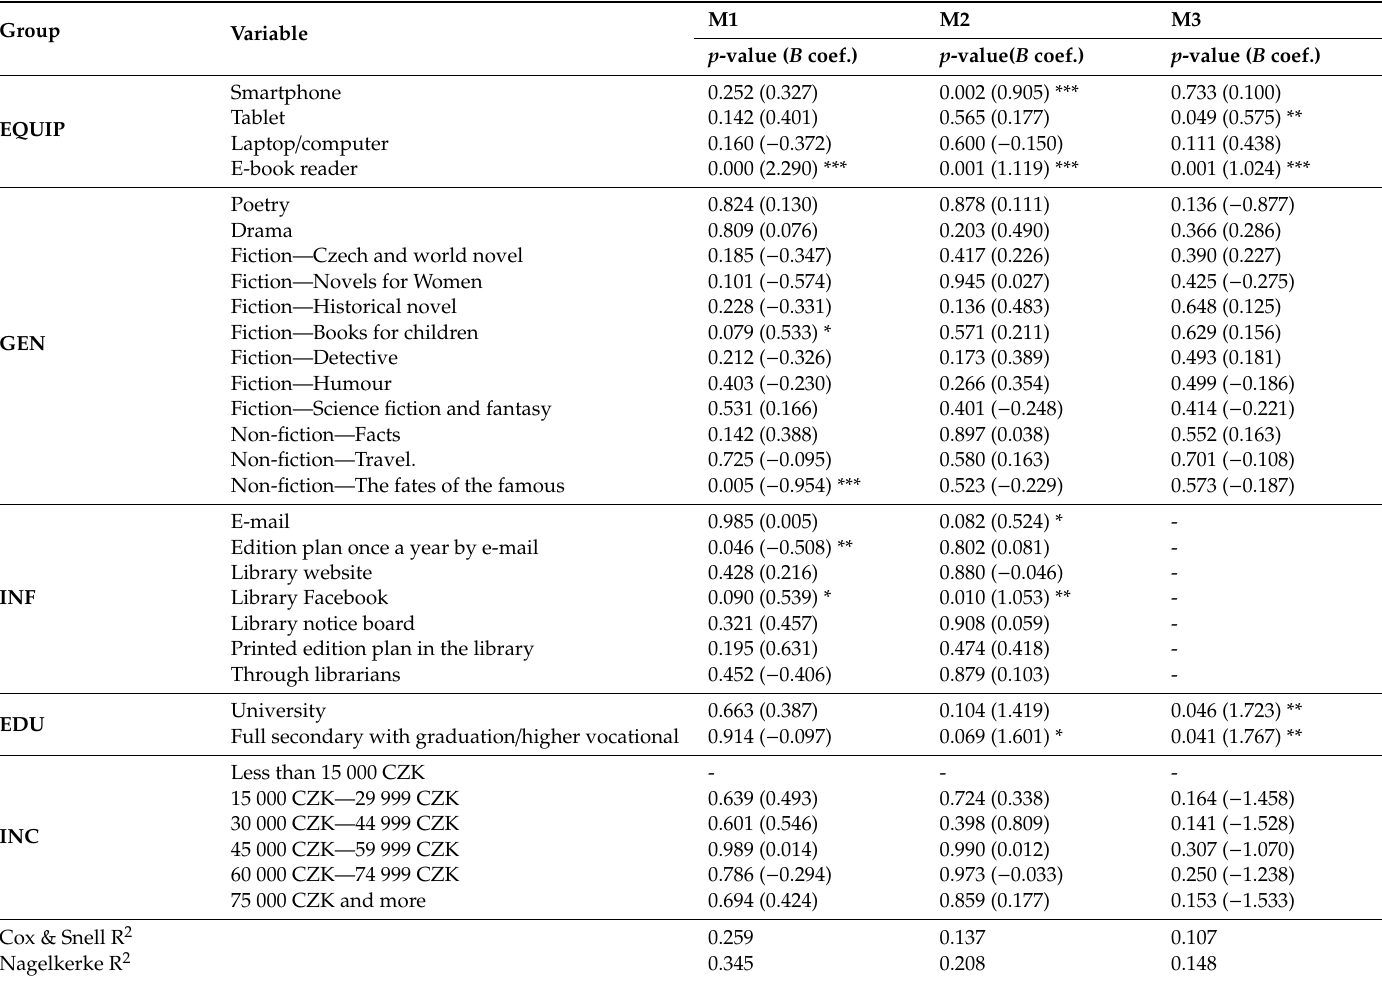
Table 6. The readers of e-books: Economically